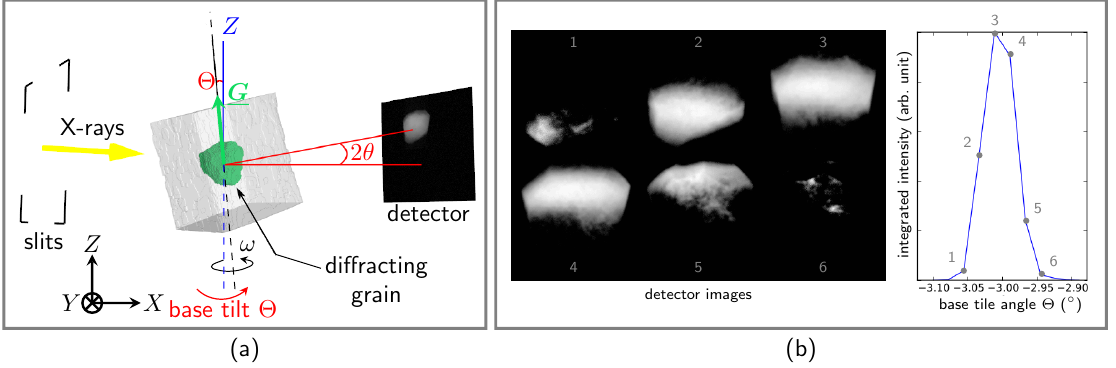
Figure 1. Schematics of the topotomographic alignment: ( a ) a scattering vector is put on the rotation axis ( ω ) , and the whole setup is tilted by the nominal value Θ = θ Bragg ; ( b ) example of integrated detector intensity to build the rocking